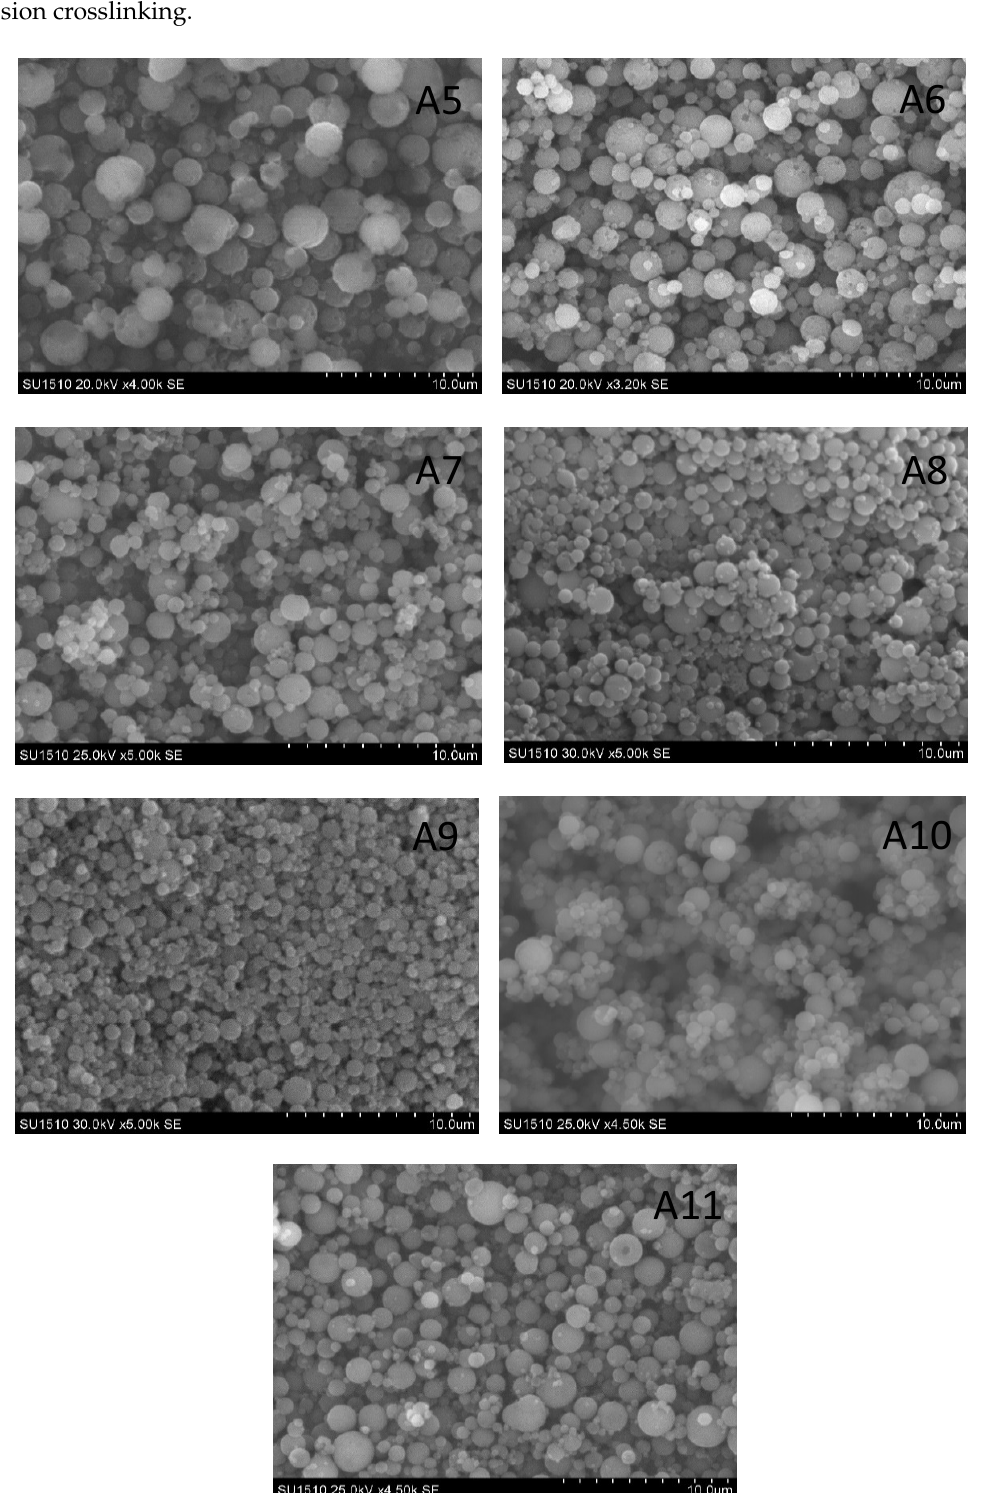
Figure 5. Micrographs SEM of CPH (magnification graphical bar length A5–A11:10 μ m).